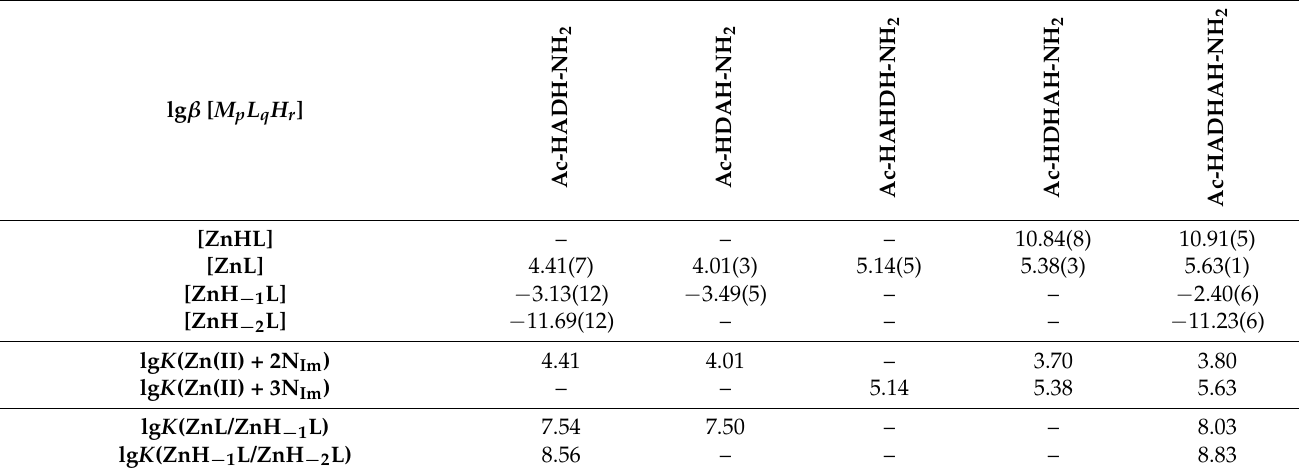
Table 7. Stability constants (log β ) and derived equilibrium constants of complexes formed in